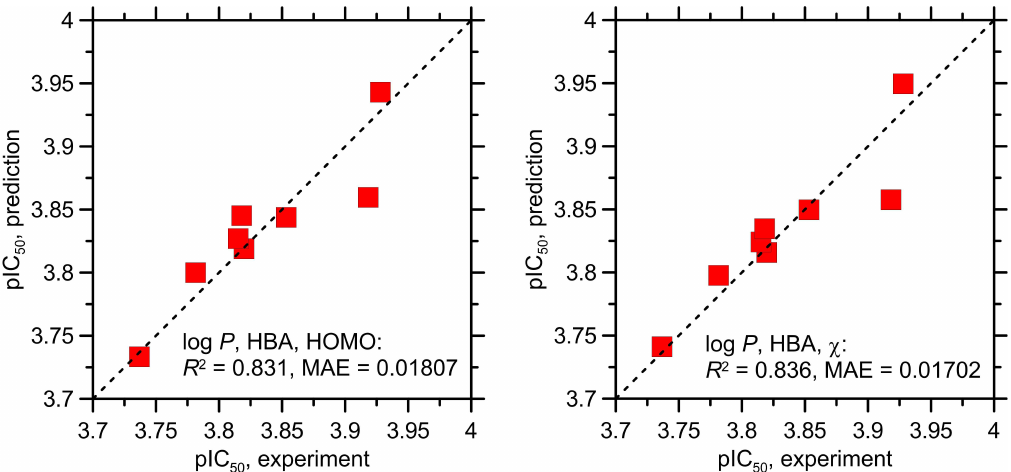
Figure 3. The comparison of the experimental pIC 50 = − log(IC 50 ) values with the predictions of the two 3-parameter QSAR models. See details in the